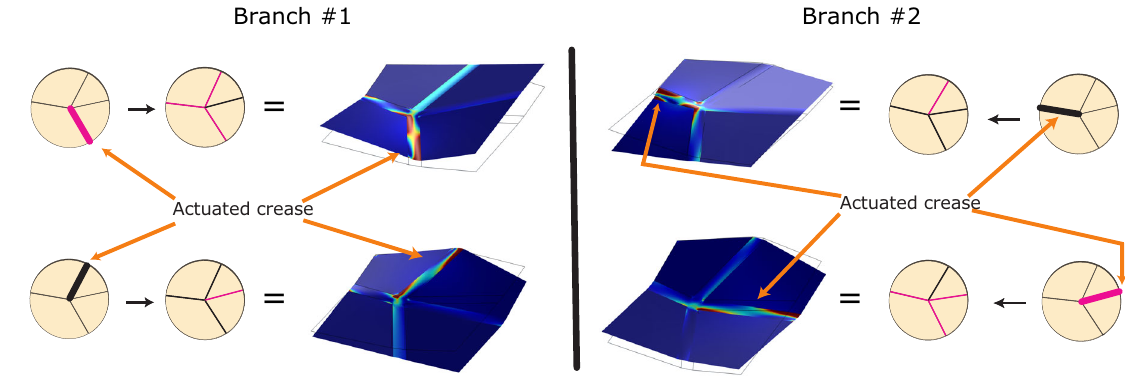
FIG. 9. Finite-element models of realistic sheets, simulated with COMSOL Multiphysics, show that the mechanical advantage rule identifies the right folding branch. When a torque is applied to just one crease, the resulting branch is predicted by the mechanical advantage rule [Fig. 2(c)]. We used the COMSOL shell model to simulate folding a realistic origami vertex (experiencing elastic strains). The folded configurations match those expected from our simplified vertex model defined only by vertex constraints, even though the COMSOL model accounts for many real-world complications not accounted for by our simple model (e.g., finite crease stiffness and thickness, delocalized bending and stretching). The pattern parameters are length approximately 0.2 m, crease width 0.015 m, thickness 10 − 4 m. Material parameters of the faces are density ρ ¼ 1760 kg = m 3 , Young ’ s modulus Y ¼ 8 × 10 8 Pa. Material parameters of